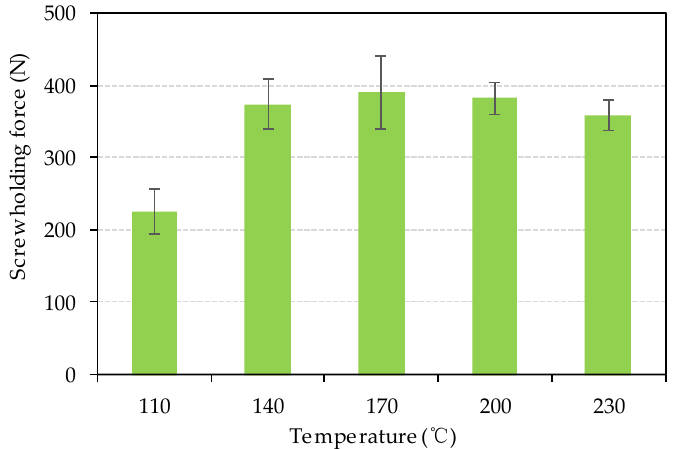
Figure 12. Screw-holding force of bio-board at different temperature (P < 0.05).